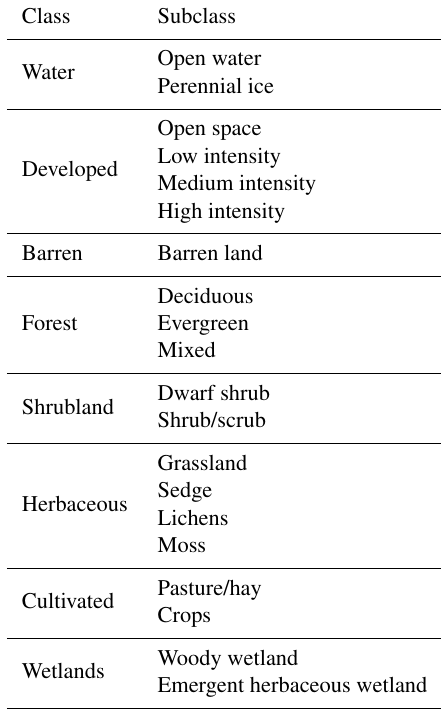
Table 2. Land cover classification by